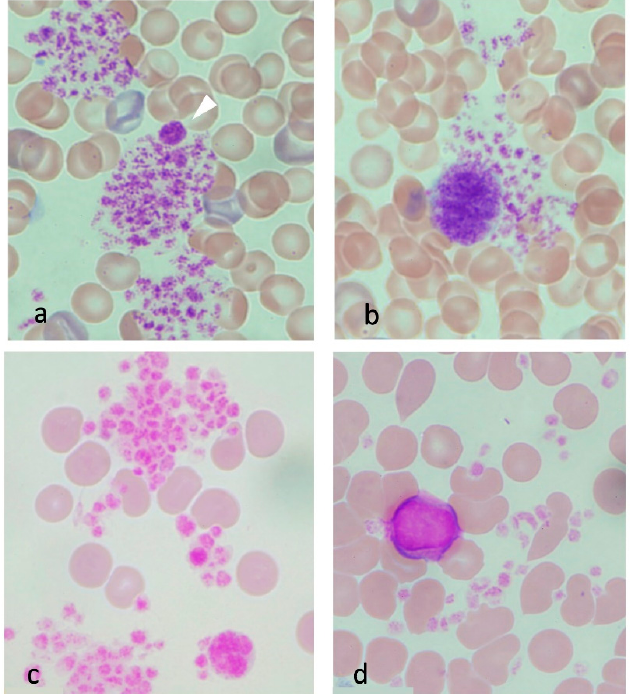
Figure 4. Platelets in severe and moderate heatstroke. Platelet aggregation was not seen in the samples from healthy control rats. By contrast, it was frequently seen in the samples from severe heatstroke rats ( a ). In addition, a large platelet (arrowhead) and a giant platelet are often observed ( b ). The presence of these immature platelets will be the reaction to platelet aggregation. Platelet aggregation was also seen in moderate heatstroke model of rats at 90 min (core body temperature was approximately 41.5 °C, ( c ). The aggregation became less frequent at 120 min when the body temperature returned to 37.5 ◦ C ( d ).